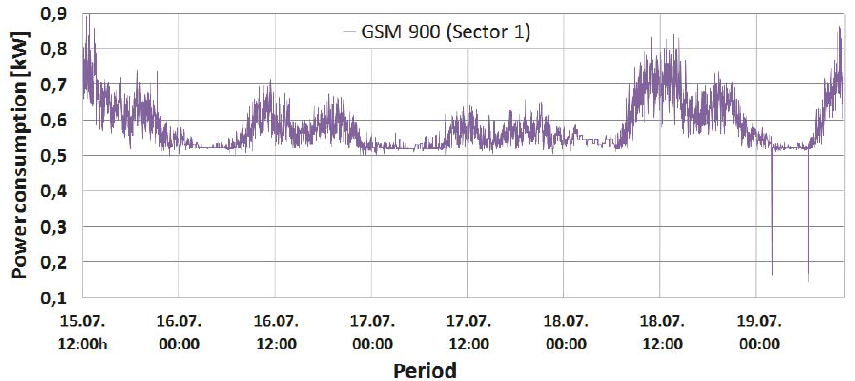
Figure 4. Power consumption of GSM 900 (Sector 1) BS